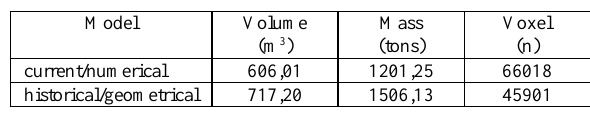
Table 4. The geometric characteristics of two voxel models